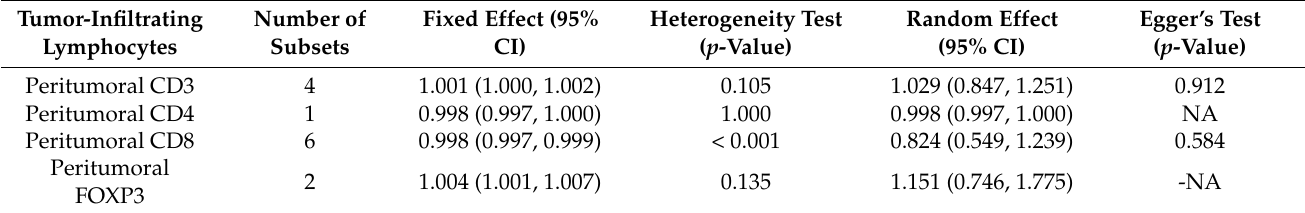
Table 3. Correlation between peritumoral infiltrating lymphocytes and overall survival in pancreatic ductal adenocarcinoma. Tumor-Infiltrating